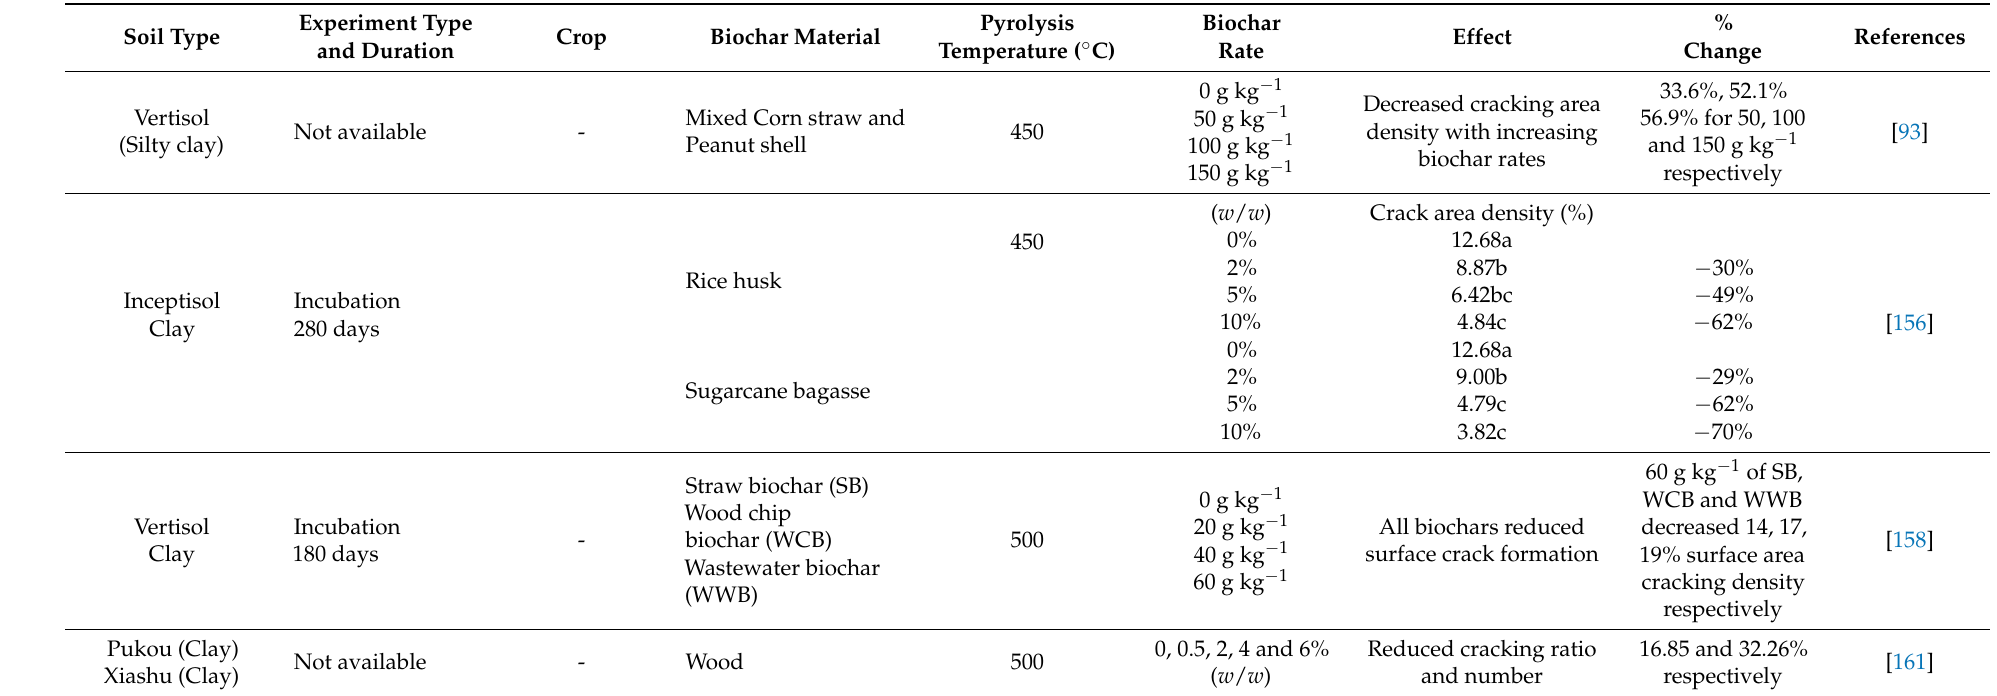
Table 8. Impact of biochar on recovering cracking parameters of different types of